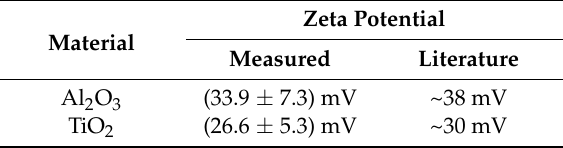
Table 3. Zeta potential of the inner membrane surfaces at pH 2